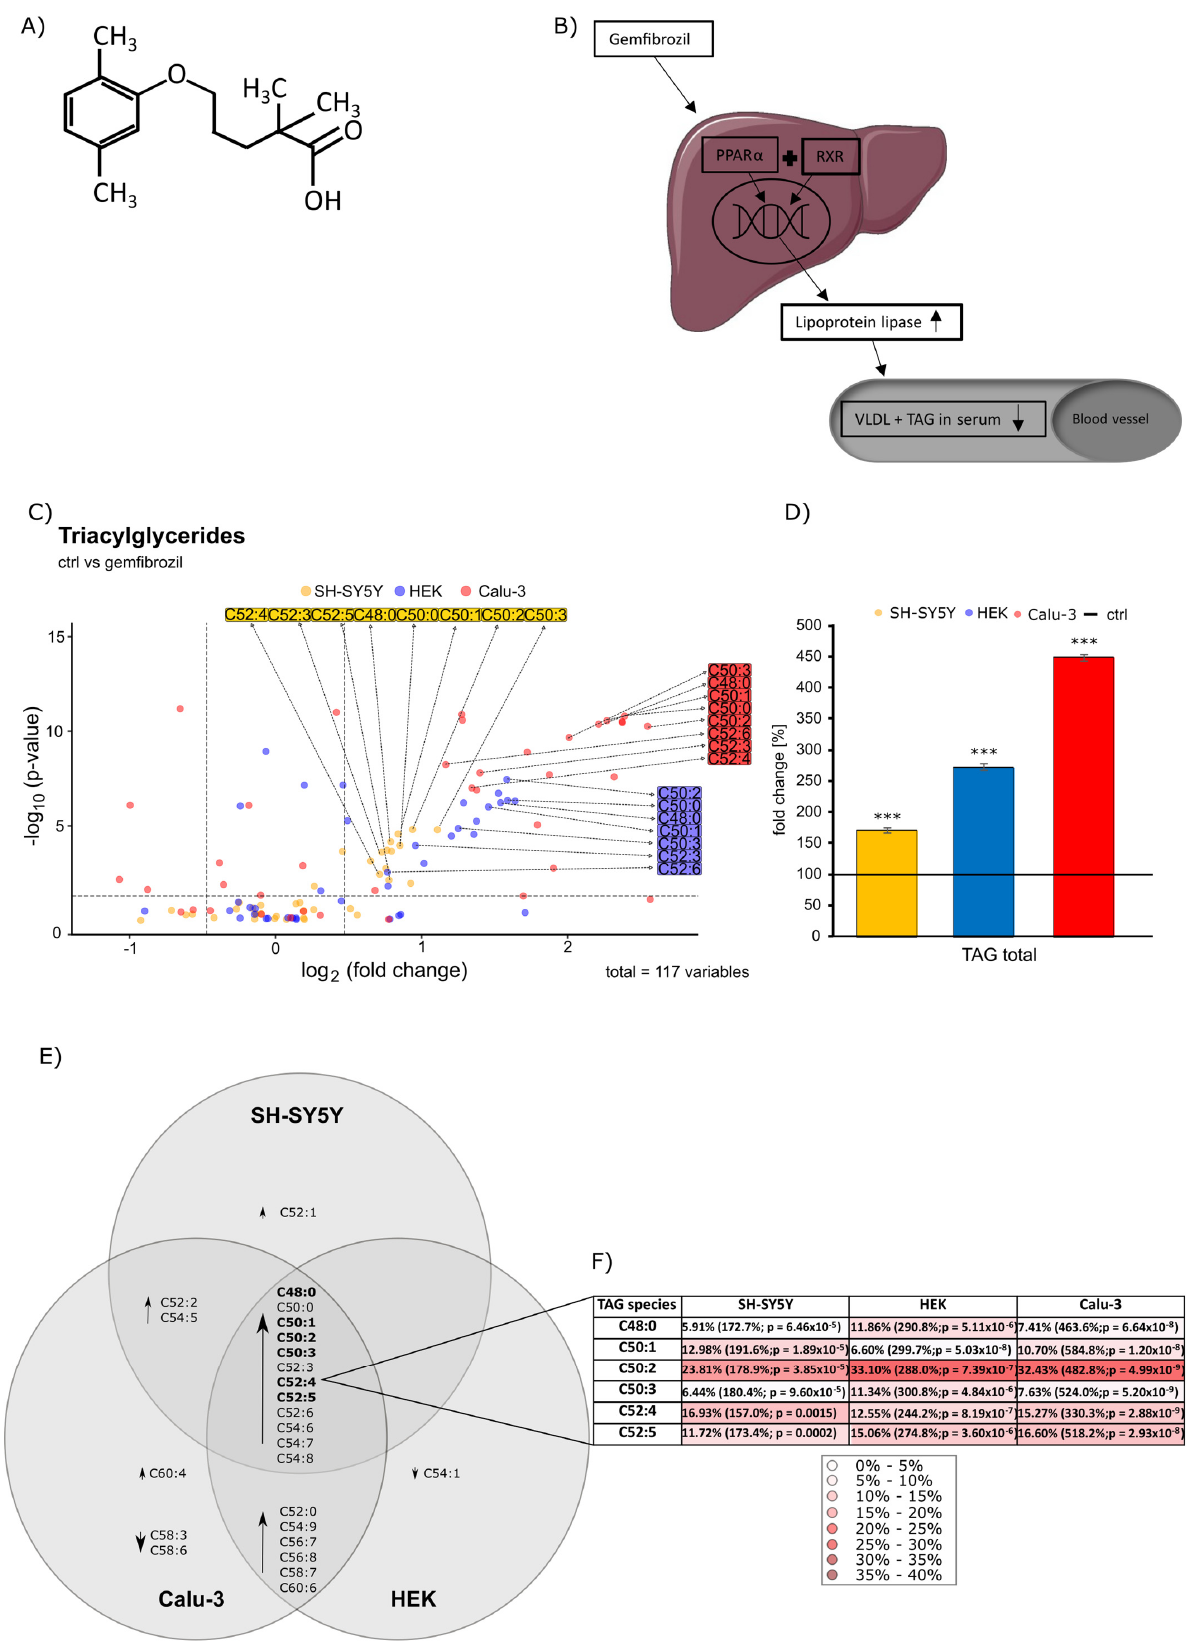
Figure 1. ( A ) chemical structure of gemfibrozil ( B ) Schematic representation of the mechanism of action of gemfibrozil in interaction with PPAR α and RXR and their gene regulatory influence